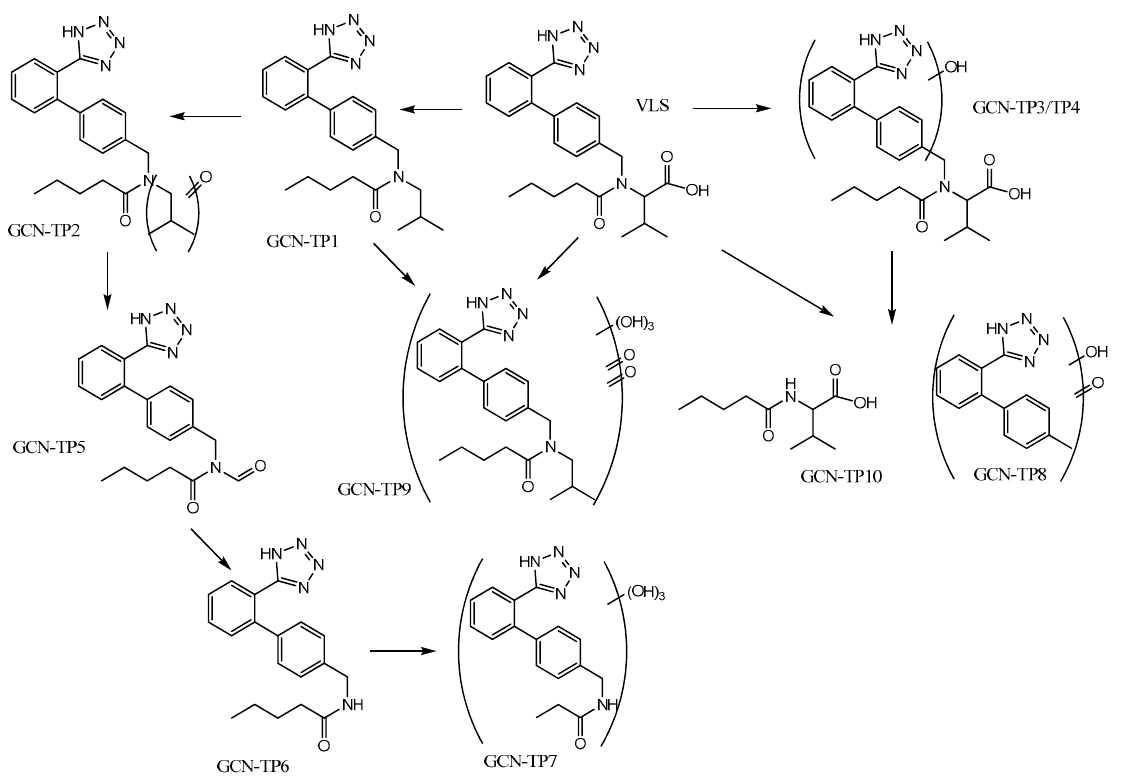
Figure 4. Proposed degradation pathways of valsartan by the g-C 3 N 4 photocatalytic oxidation.